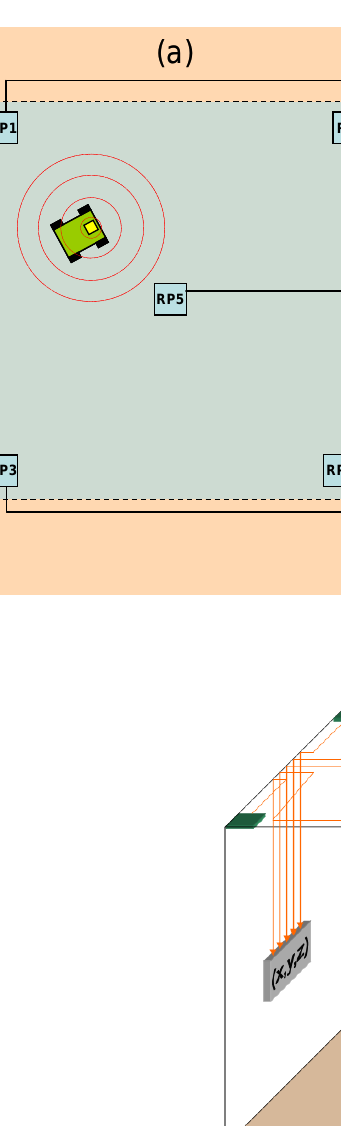
Figure 1. System block diagram.